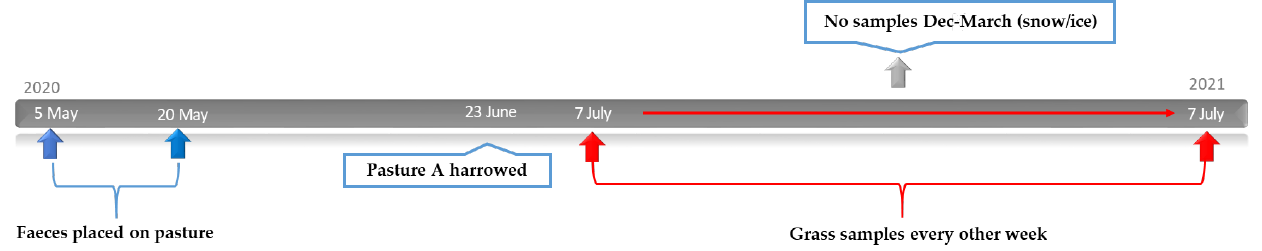
Figure 2. Schematic overview of the grass sampling (pasture A and pasture B) in the faecal removal and harrowing studies. ( A ) Pasture A had faeces removed/was harrowed and ( B ) pasture B served as the control. Grass was collected by walking over each pasture in a zigzag pattern in two directions (dashed vs. solid line). A pinch of grass, approximately 0.5 cm in diameter, was cut close to the ground every seventh step.